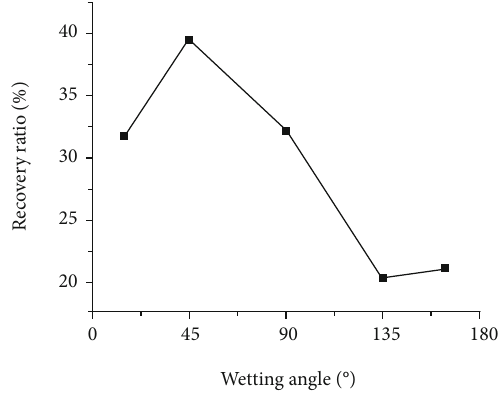
Figure 11: Recovery e ffi ciency versus contact